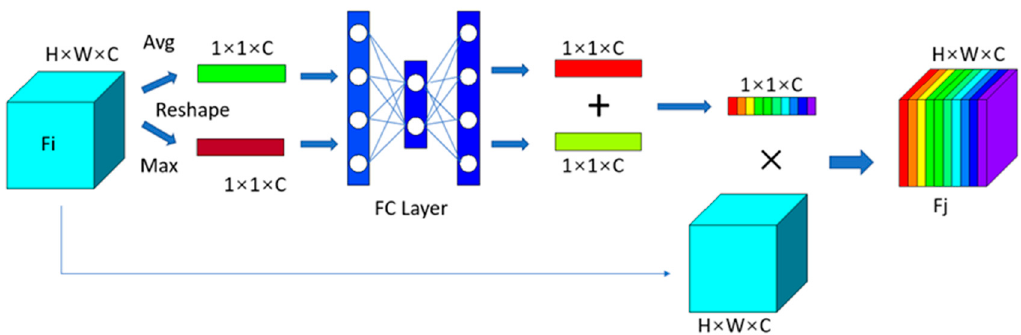
Figure 2. Structure of the channel attention module. H, W, and C denote the height, width, and channel, respectively, representing the input size.